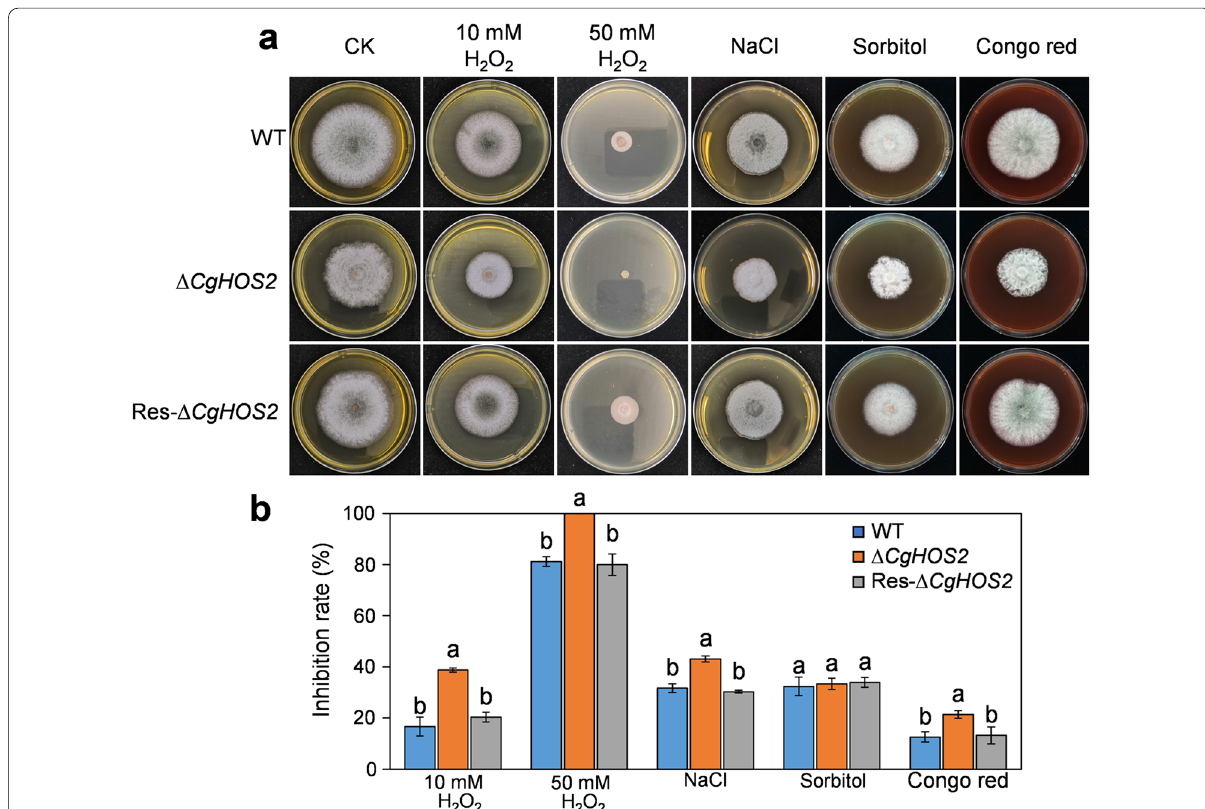
Fig. 4 CgHOS2 is involved in stress tolerance. a Colony morphology of fungi incubated on PDA media supplemented with 10 or 50 mmol/L H 2 O 2 , 0.7 mol/L NaCl, 1 mol/L sorbitol, or 0.25 mg/L Congo red for 6 days. b Column chart showing the inhibition rate of the tested chemicals. Strains cultured under nonstress conditions were used as controls. The inhibition rate was calculated with the following formula: Inhibition ratio (%) of control sample – Area of the treated sample)/(Area of control sample) columns with different letters indicate significant differences ( P <